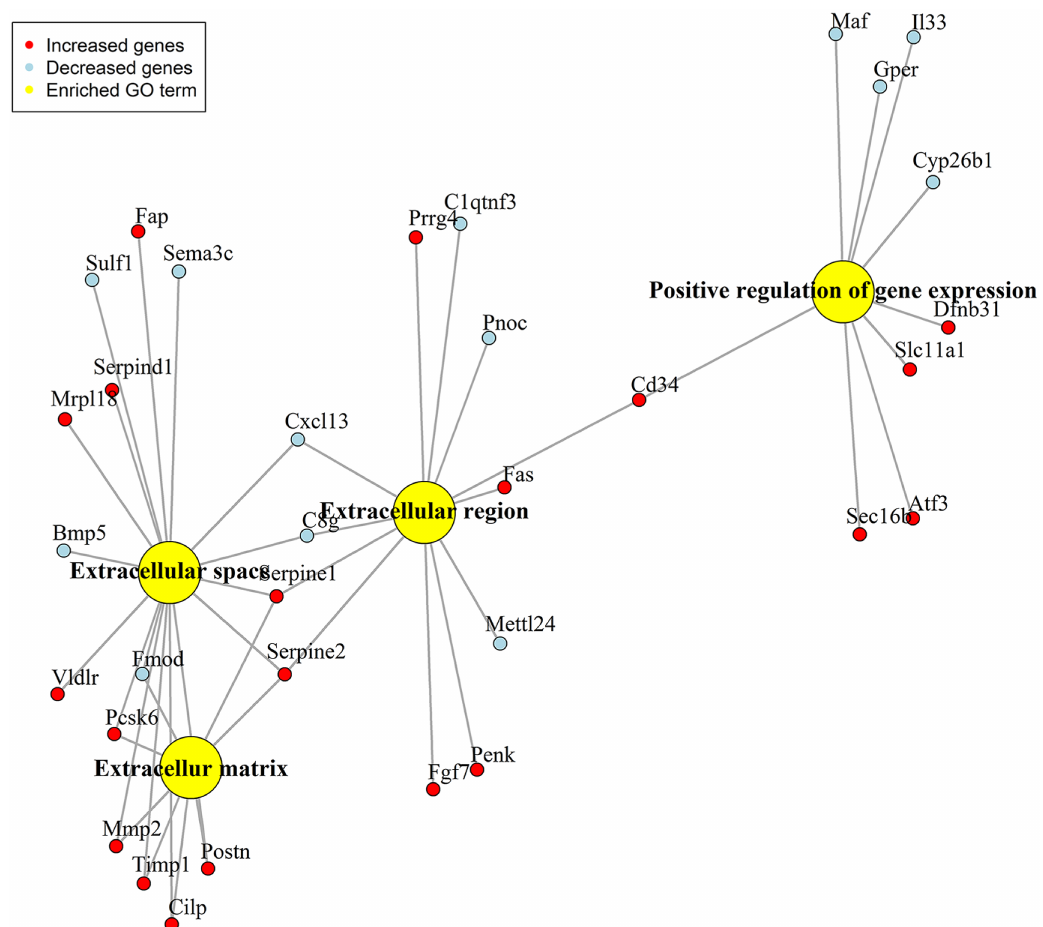
Fig 1. GO overrepresentation analysis network. Network of the differentiallyexpressed genes (q = 0) in the MCAs from SHRs (n = 5) comparedto WKY rats (n = 5).